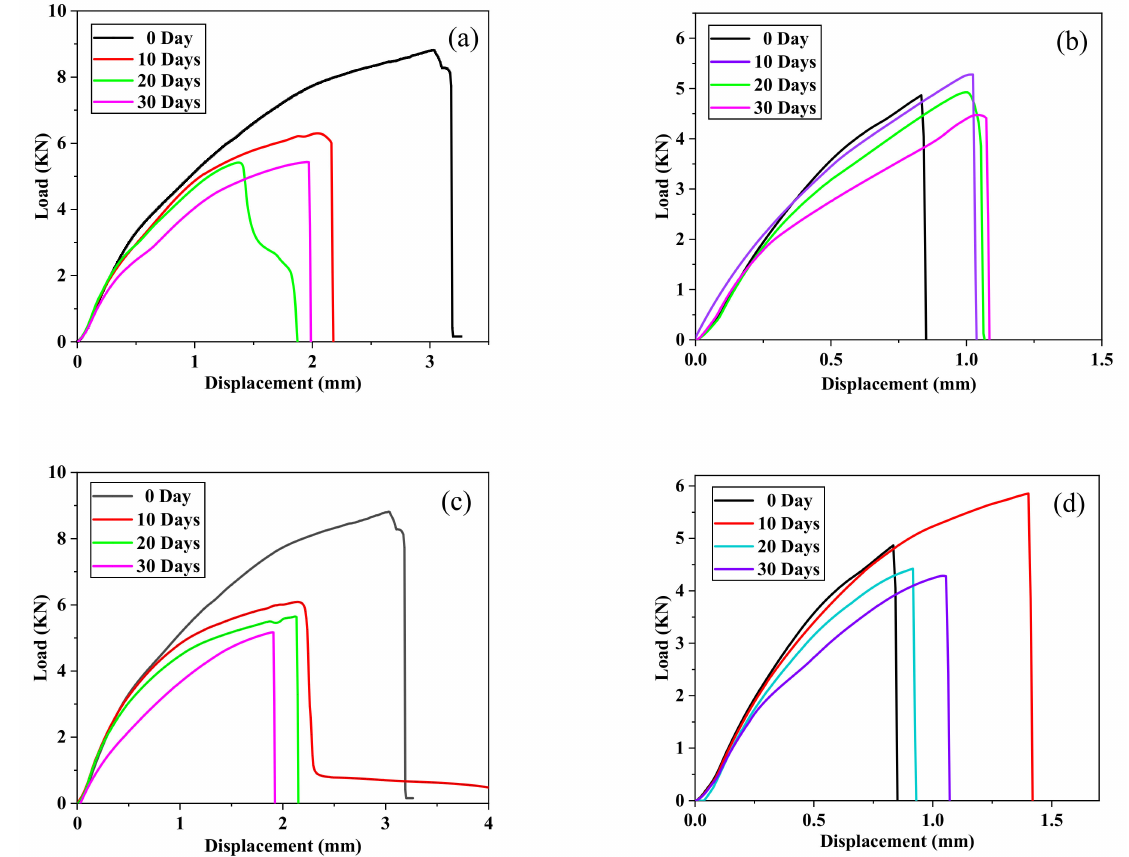
Figure 11. Load–displacement curves: ( a ) Araldite® 2012 joints in 80 ◦ C/95%RH, ( b ) Araldite® 2014 joints in 80 ◦ C/95%RH, ( c ) Araldite® 2012 joints in 80 ◦ C/pure water, and ( d ) Araldite® 2014 joints in 80 ◦ C/pure